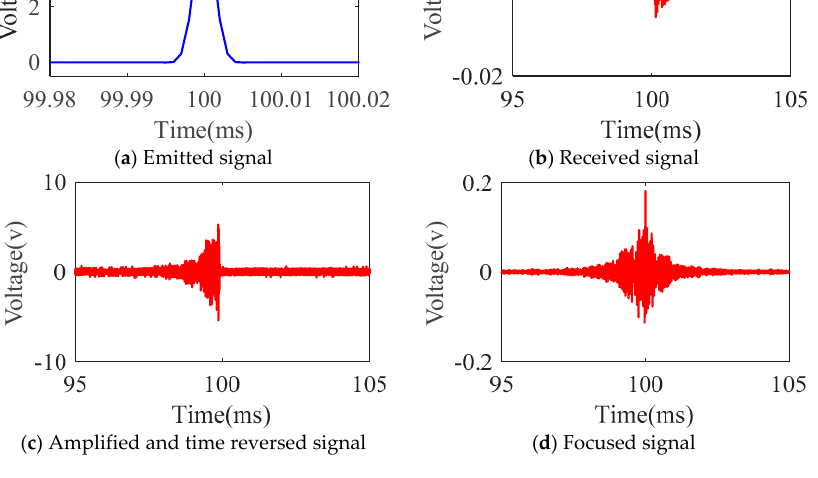
Figure 11. Signal after 15 h.